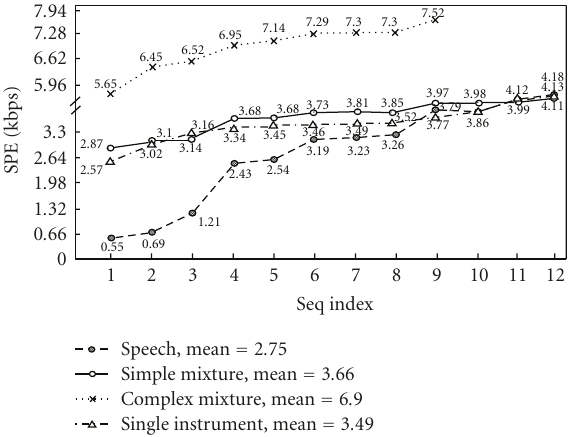
Figure 15: Perceptual spatial information of stereo sequences sampled at 44.1